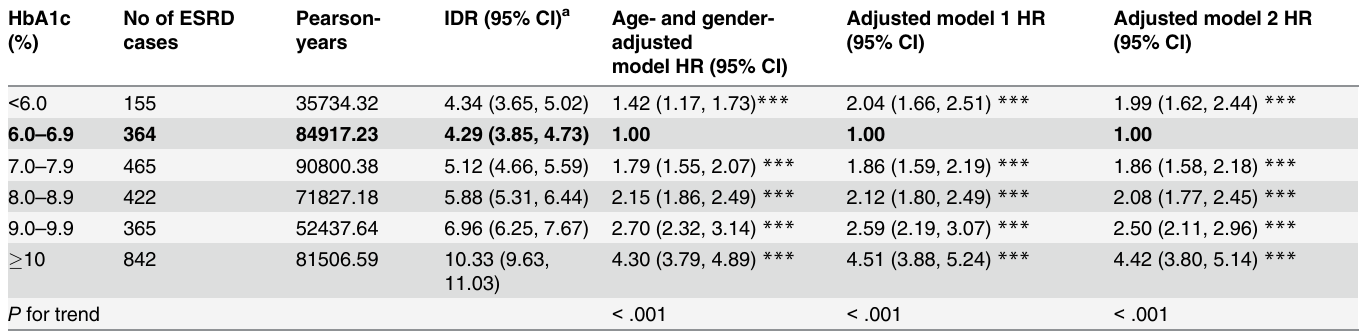
Table 2. ESRD incidence and risk at different HbA1c